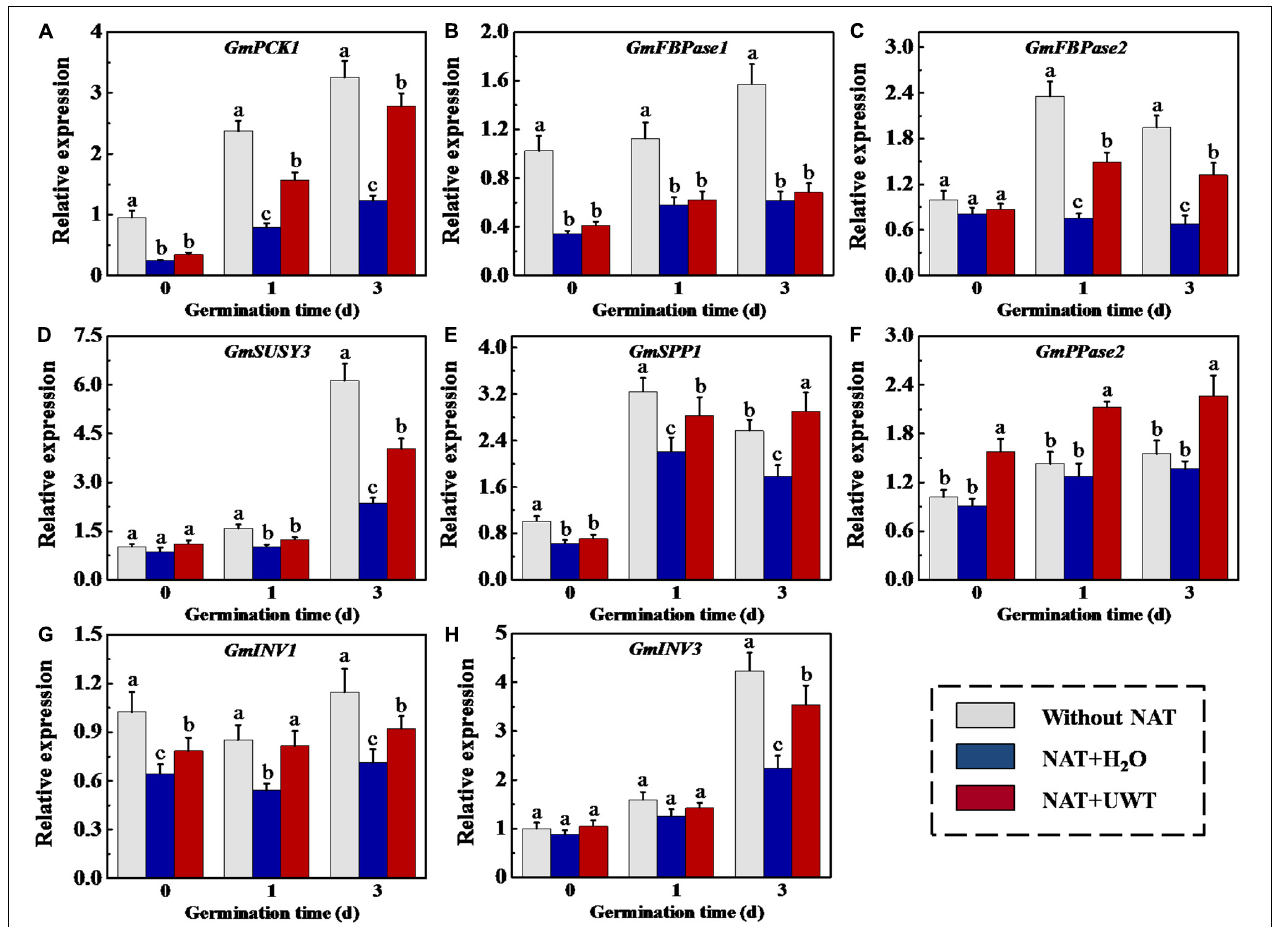
FIGURE 8 | Ultrasonic waves treatment increased the transcriptional levels of GmPCK1 (A) , GmFBPase1 (B) , GmFBPase2 (C) , GmSUSY3 (D) , GmSPP1 (E) , GmPPase2 (F) , GmINV1 (G) , and Gm INV3 (H) of aged soybean seeds during early germination. Without NAT, fresh seeds without naturally aging treatment (NAT); NAT + H 2 O, Seeds stored for 12 months with H 2 O; NAT + UWT, NAT seeds with ultrasonic waves treatment (UWT). The RT-PCR assays were performed with four independent biological replicates and three technical replicates. Different lowercase letters in the same column indicate significant differences between different treatments ( p <